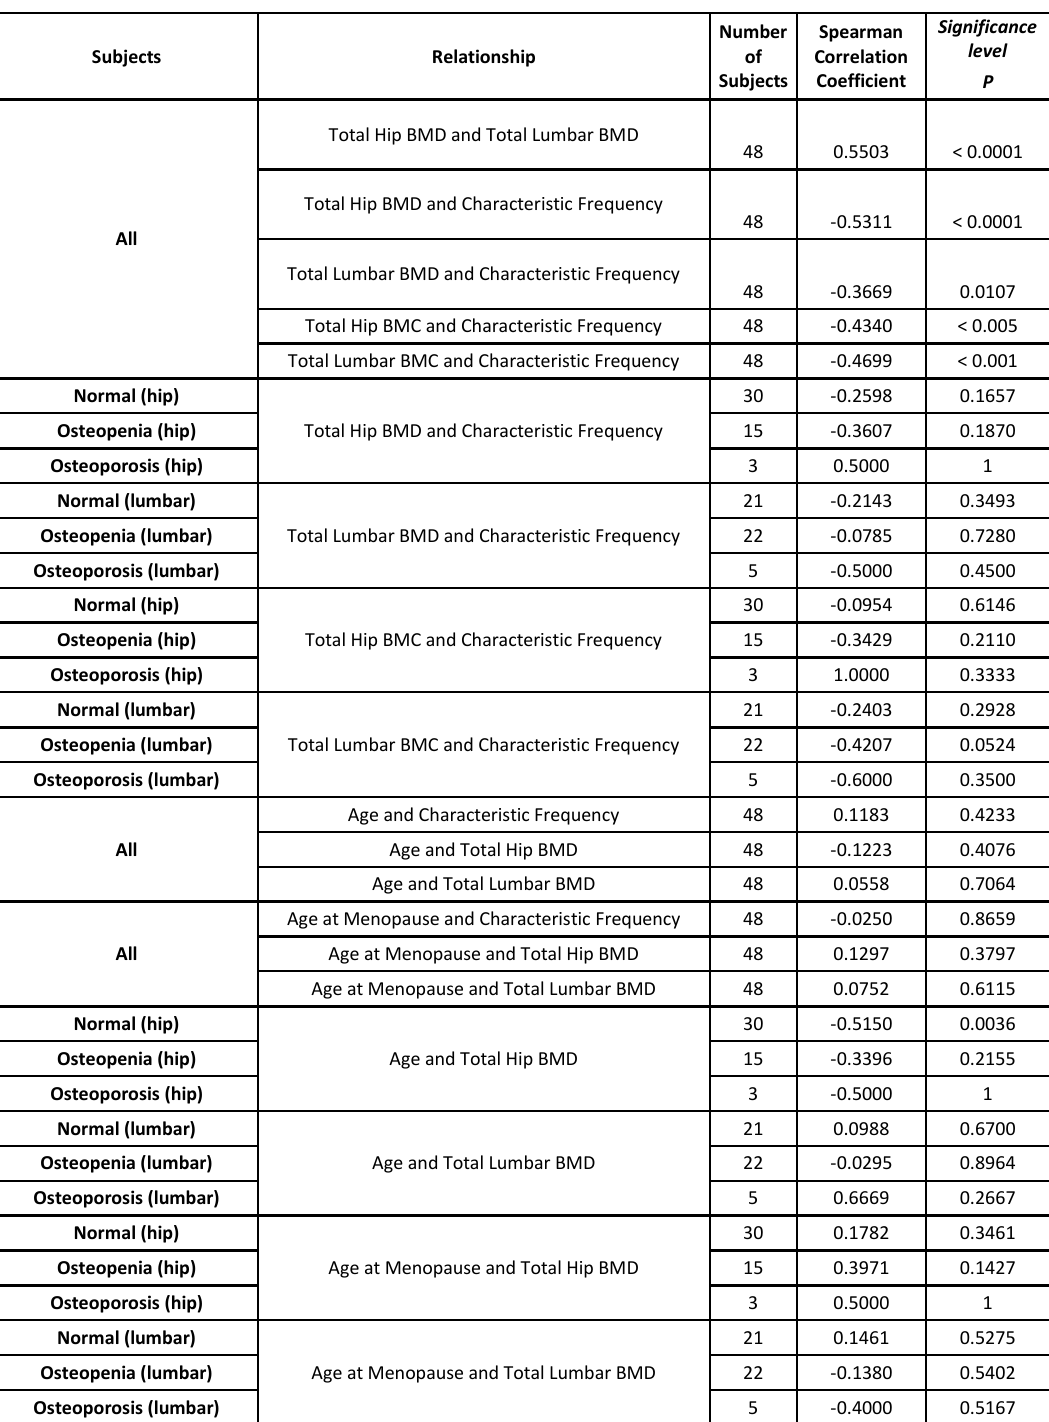
Table 4. The relationship between lumbar spine or hip BMD, the dominant arm characteristic frequency, age, and age at